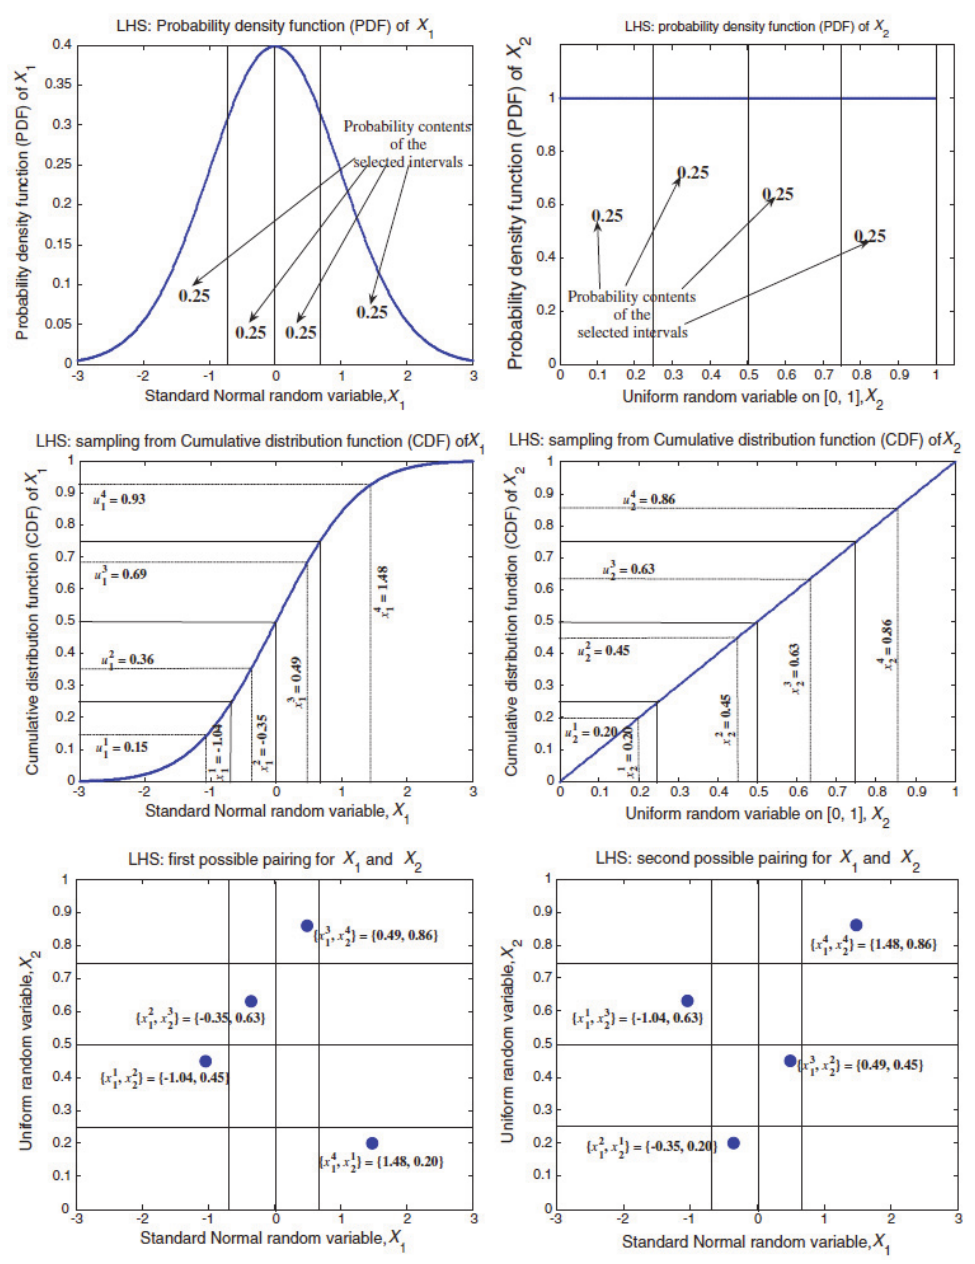
Fig. 1. samples of LHS for the creation of a model size of NT=4 from two rvs{X 1 , X 2 } with X 1 standard (first) and X2 consistent on (0, 1) (sec- ond). Leading pdfs (bulky tight lines): third and fourth pdfs (bulky tight lines) and equivalent separated breaks of similar likelihood (slender tight lines); fifth and sixth two likely Latin hypercube examples of size NT=4 rising from two dissimilar likely accidental pairings (dots). In case of mathematical modeling, a square grid comprises of model location of a Latin square provided that the model remains in every row and column. Method of Latin Hyper Cube sampling has been defined for drawing N sample of (n) Independent variable [ X j : j=1, 2,…,n] that each element has T distribution of [qj(0) : j=1, 2,…,n] (Zio, 2013). The range of each variable was divided into the discrete unit. Afterward, according to each variable probability distribution [qj(0) : interval in number of N T j=1, 2,…,n], a quantity of variable is selected for each distance randomly . These N T ، organized couples are mixed accidentally without being replaced with NT values (cid:1850) (cid:2871)(cid:3038) k=1,2,…, N T of X 3 to form the N T ordered